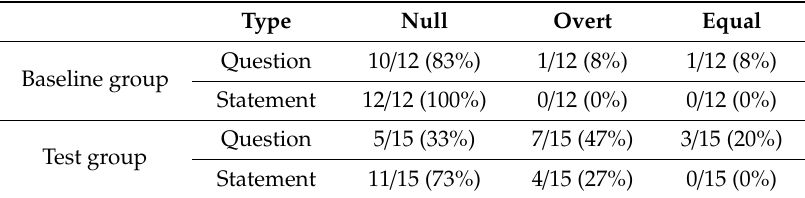
Table 6. Participants who preferred null or overt C2